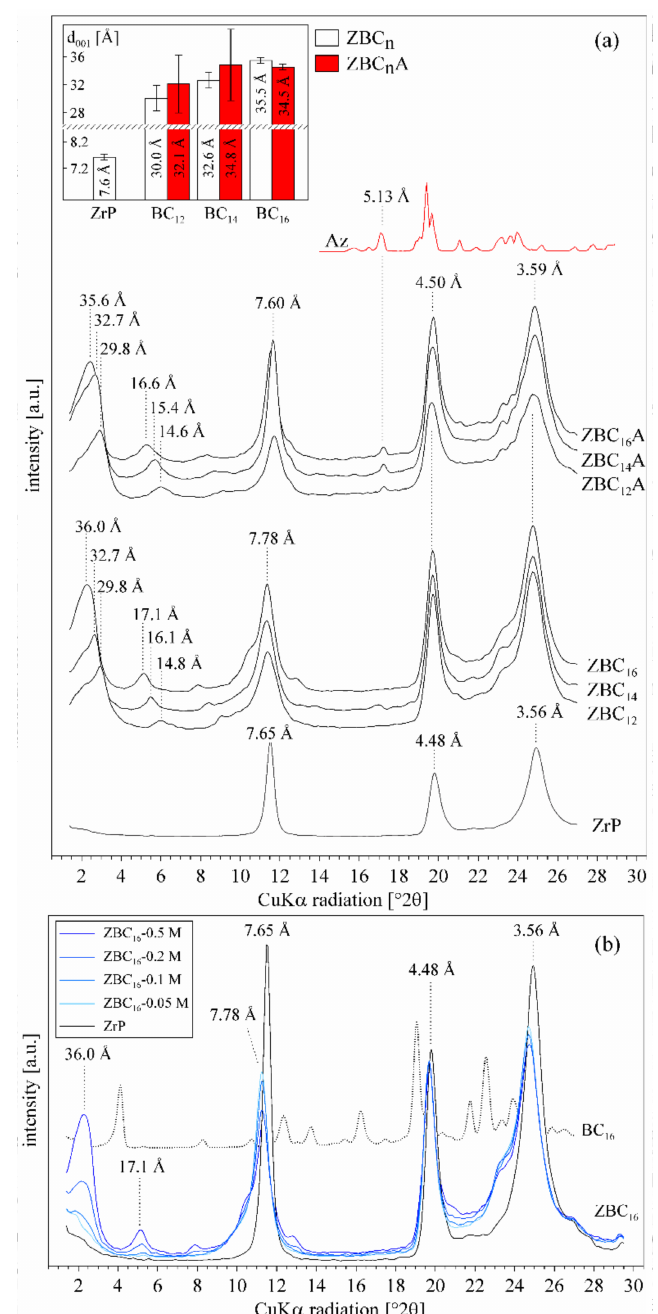
Figure 1. ( a ) The XRD patterns of pure ZrP sample, ZrP intercalated with benzylalkylammonium salts (ZBC 12 , ZBC 14 , ZBC 16 ), with azobenzene (ZBC 12 A, ZBC 14 A, ZBC 16 A), and of the pure azobenzene (Az). The basal spacing values of the samples are compiled in the inner graph; ( b ) the XRD patterns of ZBC 16 samples with di ff erent BC 16